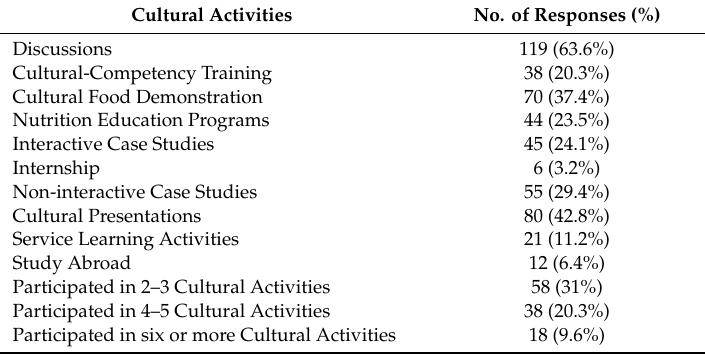
Table 3. Dietetic-Related Cultural Activities ( n =